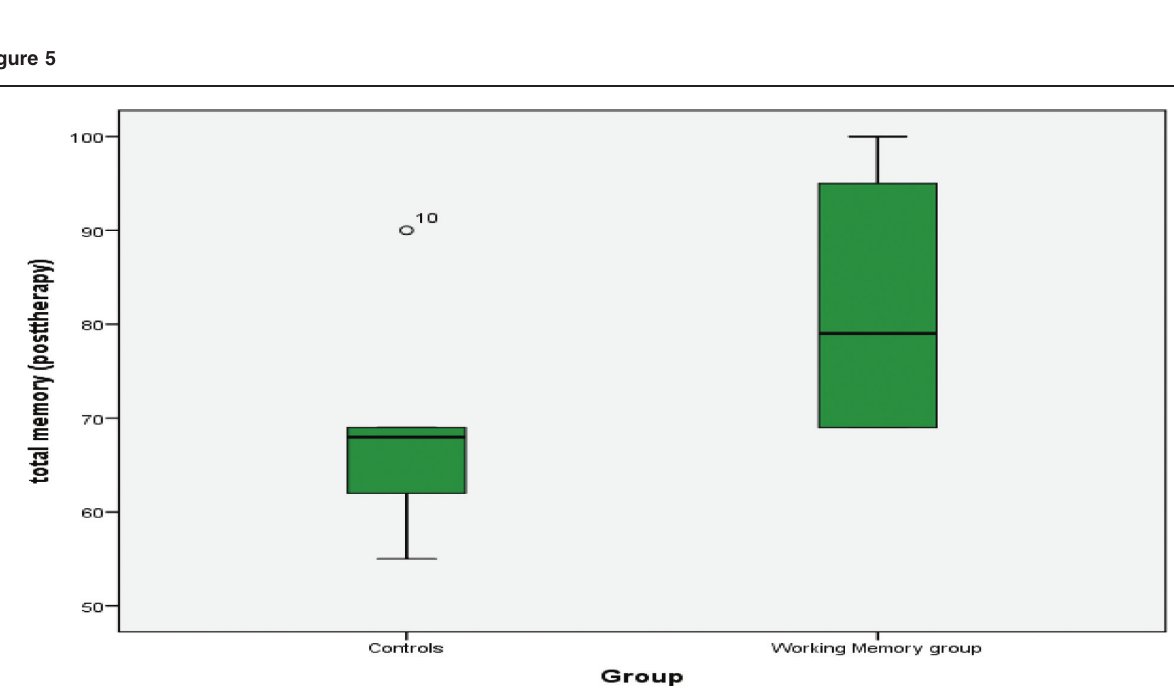
Comparison between two groups in total memory post-therapy